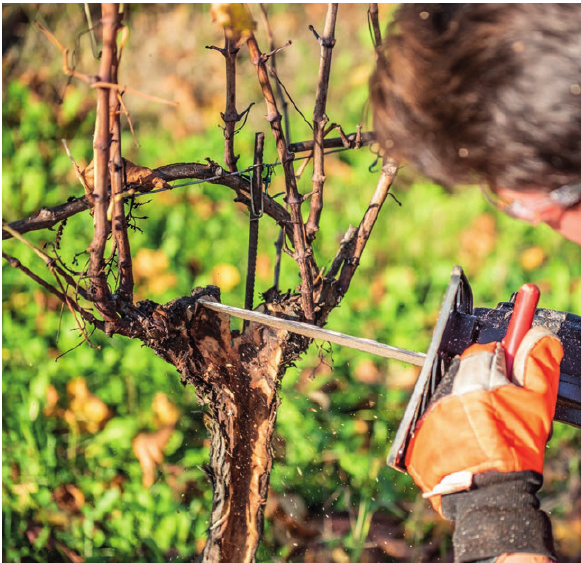
Figure 3. Illustration of the curettage technique, performed on a grapevine stock with a small chain saw (Photograph Francesco Cec-